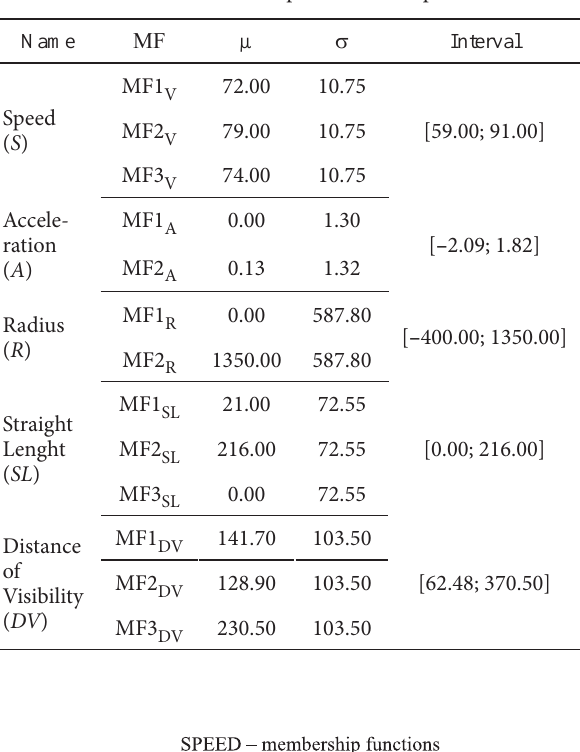
Table 1. Characteristics of the input membership